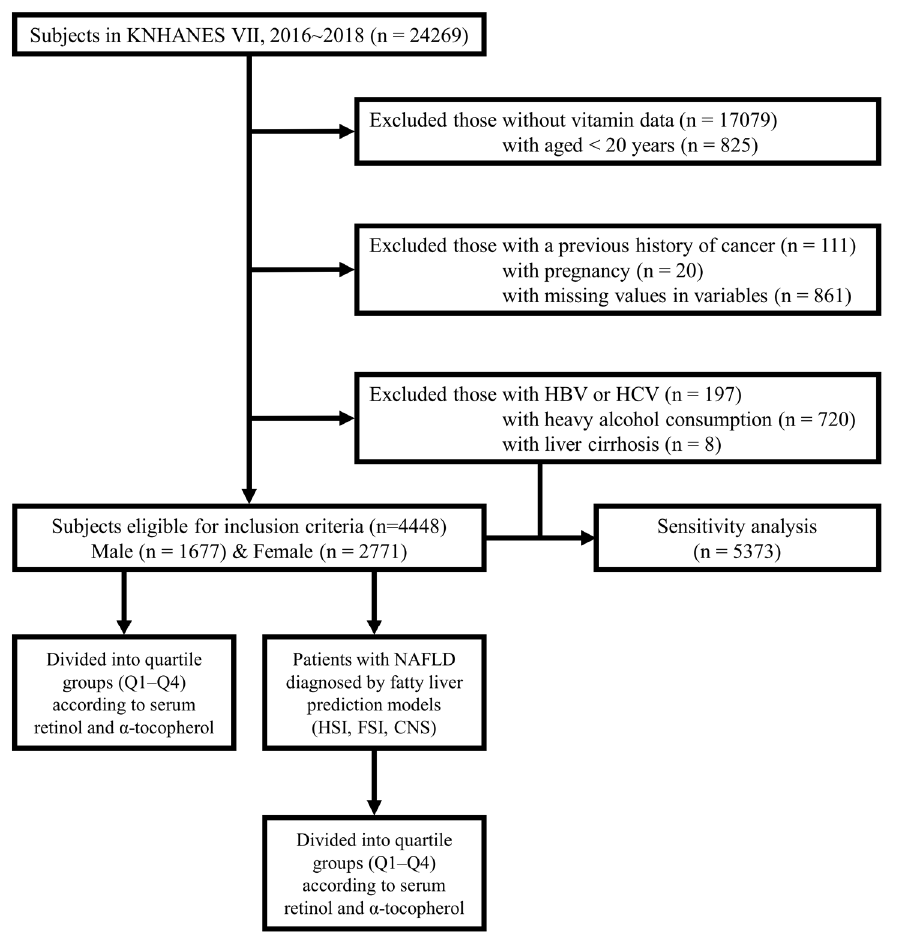
Figure 1. Flow diagram of study population. From the total 24,269 subjects retrieved from the KNHANES VII database, we excluded the following subjects: (1) 17,079 subjects without data on serum retinol and alpha ( α )-tocopherol levels; (2) 825 aged <20 years; (3) 111 with a previous history of any cancer; (4) 20 who were pregnant; and (5) 861 with missing variables. An additional 926 subjects, (1) 197 positive for HBV or HCV; (2) 720 heavy drinkers; and (3) 8 with liver cirrhosis were also excluded from the initial analysis but included in the later sensitivity analysis. Finally, 4448 subjects (1677 males and 2771 females) were included. All included individuals were divided into quartile groups according to serum retinol and α -tocopherol levels. KNHANES VII, 7th Korea National Health And Nutrition Examination Survey; HBV, hepatitis B virus; HCV, hepatitis C virus; Q, quartile; NAFLD, non-alcoholic fatty liver disease; HSI, hepatic steatosis index; FSI, Framingham steatosis index; CNS, comprehensive NAFLD